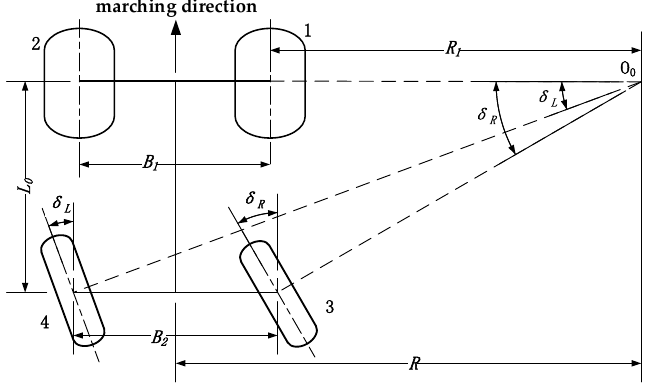
Figure 10. Diagram of turning.